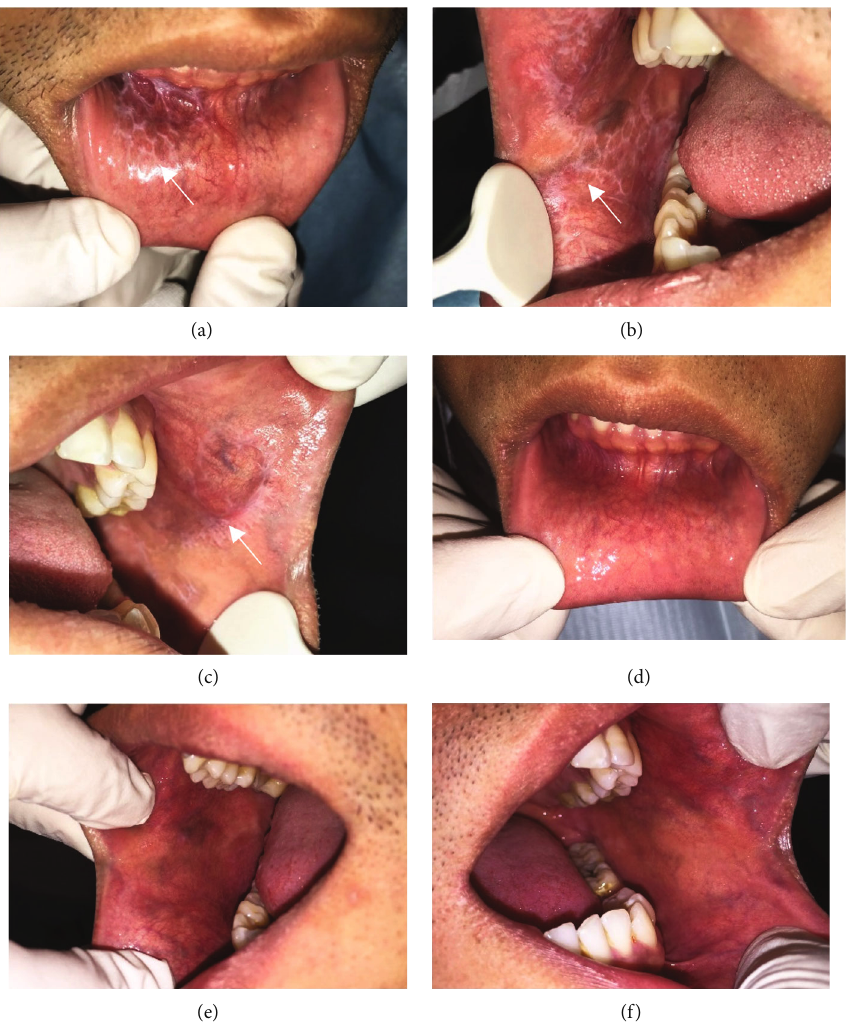
Figure 2: The clinical features of OLP in a 31-year-old man; (a) – (c). Wickham striae on the lower labial mucosa and on the right and left buccal mucosa; (d) – (f). Oral lesion completely healed after fi ve months of